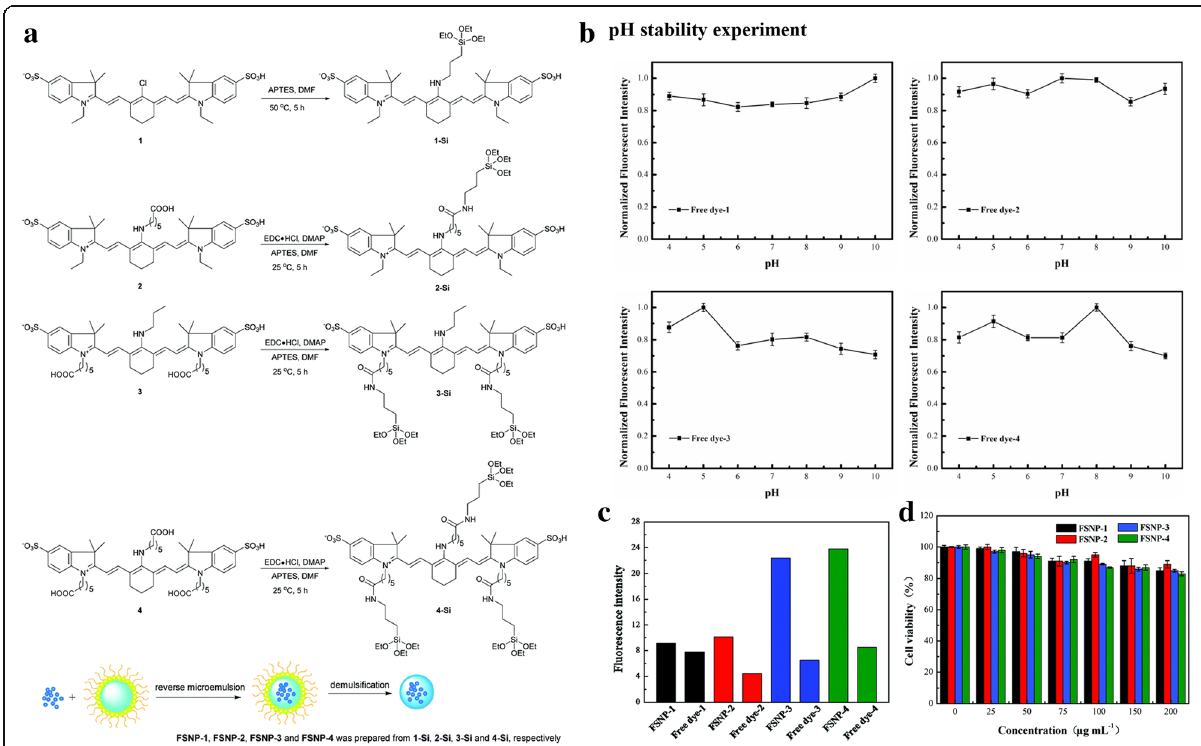
Fig. 2 a The mechanism of FSNP-1, FSNP-2, FSNP-3, and FSNP-4. b The normalized intensity in different pH values of all the samples. c Emission intensity of the FSNPs and free dyes. d Showing after incubated with FSNPs for 24 h, the viability of the raw264.7 macrophage cells [23]